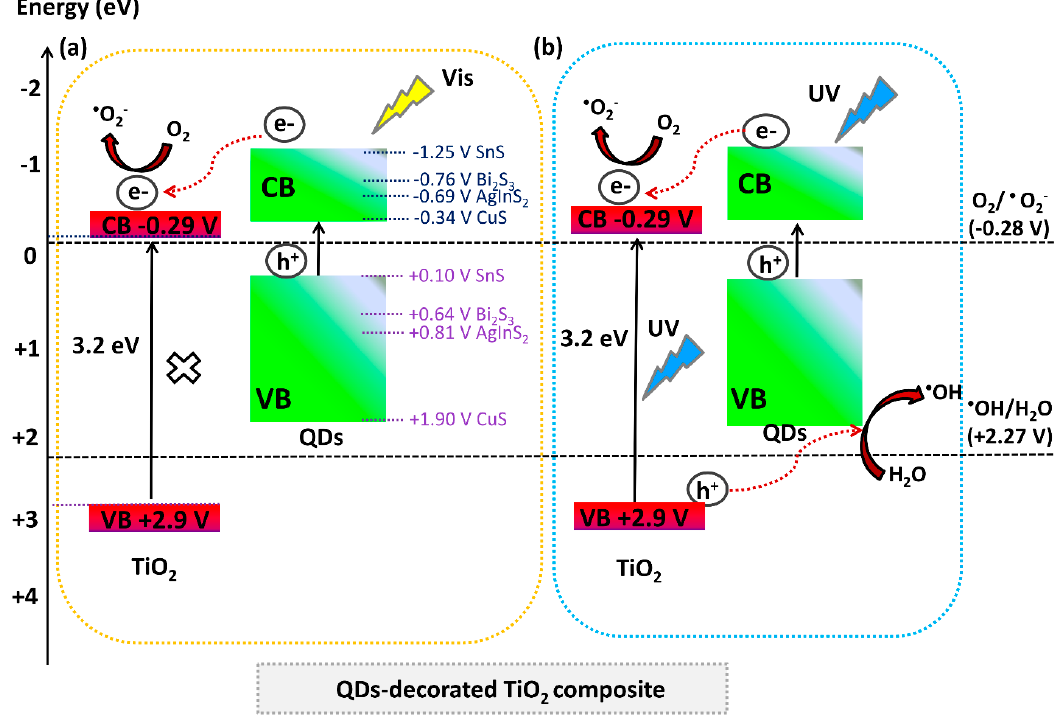
Figure 9. Proposed mechanism of photocatalytic reactions in the presence of QDs-sensitized TiO 2 composite under ( a ) visible, and ( b ) UV irradiation.